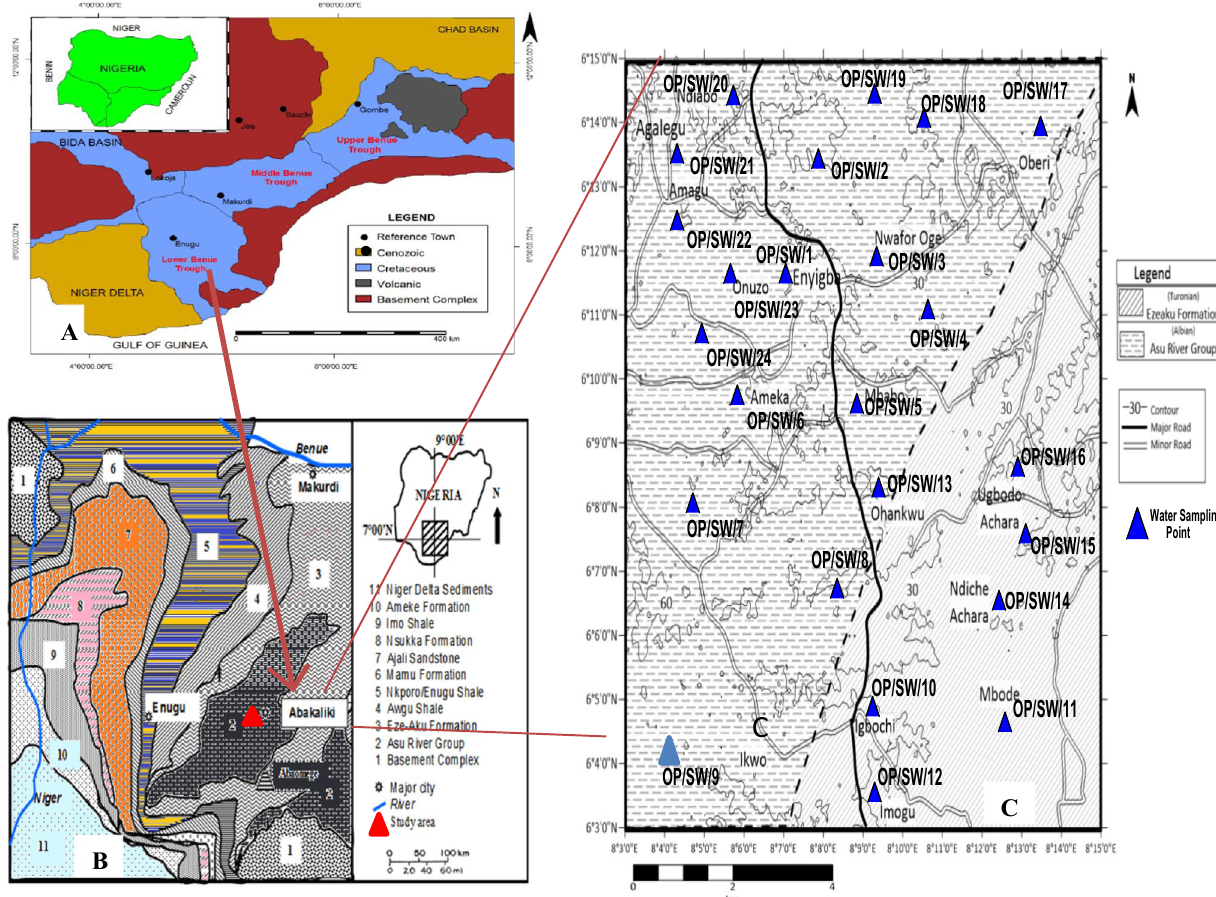
Fig. 2 a Geologic Map of the Lower Benue Trough (LBT) (Zarboski 1997). b Stratigraphic Settings of the LBT (modified from Nwajide 2013). c Geological map the study area showing dominant rock types and sample